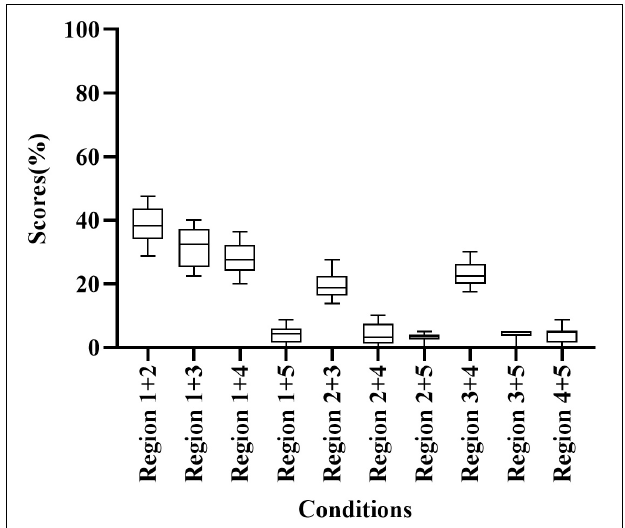
FIGURE 1 | Percent-correct scores for disyllabic word recognition using acoustic temporal envelope in two-frequency-region conditions.